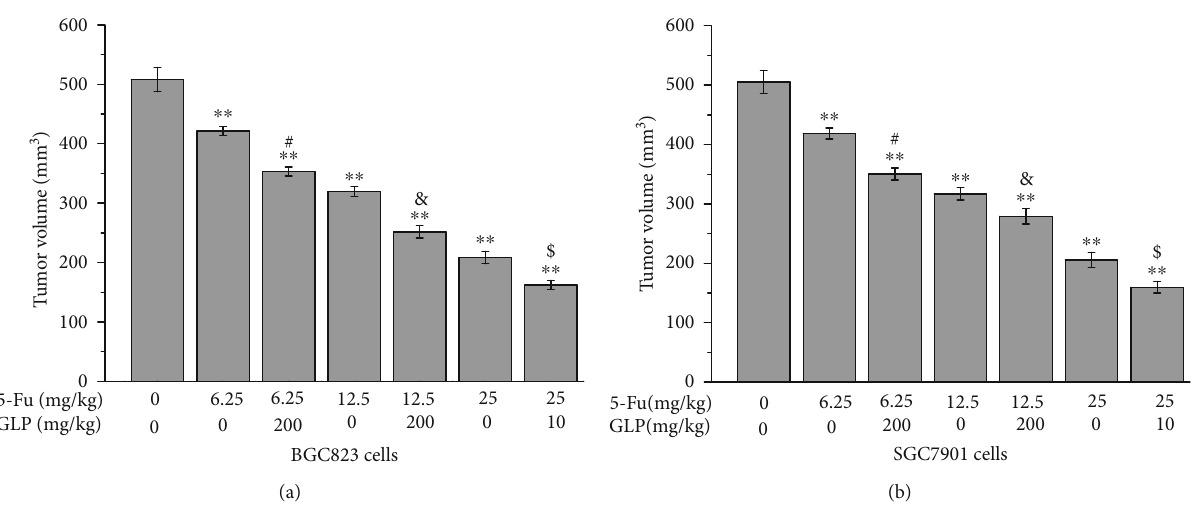
Figure 3: GLP increased the antitumor activity of 5-Fu in gastric cancer-bearing mice. (a) During the treatment of BGC823 gastric cancer- bearing mice, GLP enhanced the antitumor activity of 5-Fu at the 12 th day of administration. (b) During the treatment of SGC7901 gastric cancer-bearing mice, GLP enhanced the antitumor activity of 5-Fu at the 12 th day of administration. Data were expressed as means ± SEM ; compared with the control group, ∗ indicated p < 0 : 05 , ∗∗ indicated p < 0 : 05 ; compared with the 5-Fu (6.25mg/kg) group, # indicated p < 0 : 05 , ## indicated p < 0 : 05 ; compared with the 5-Fu (12.5mg/kg) group, & indicated p < 0 : 05 , && indicated p < 0 : 05 ; compared with the 5-Fu (25mg/kg) group, $ indicated p < 0 : 05 and $$ indicated p < 0 : 05 .